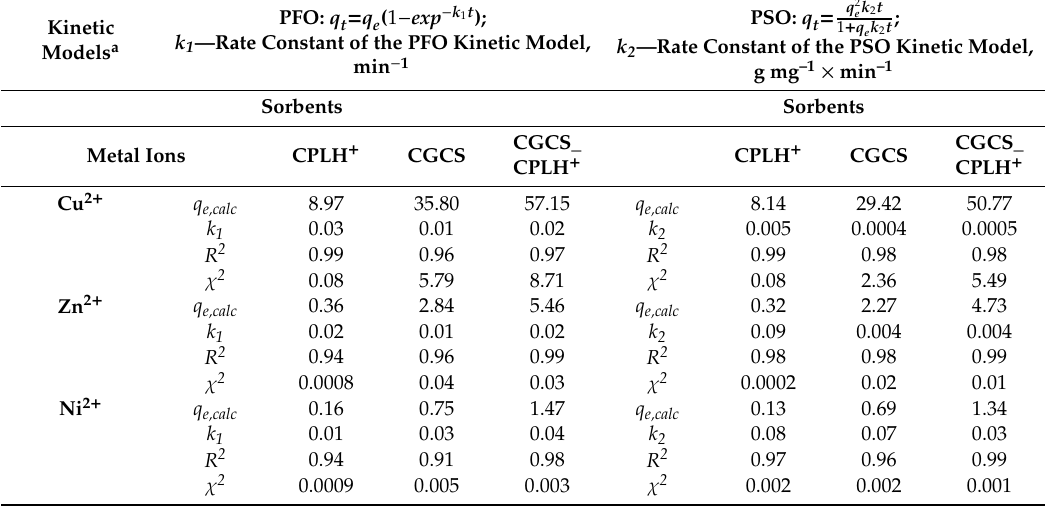
Table 1. Kinetic model parameters for the sorption of Cu 2 + , Zn 2 + , and Ni 2 + ions onto sorbents. Kinetic Models